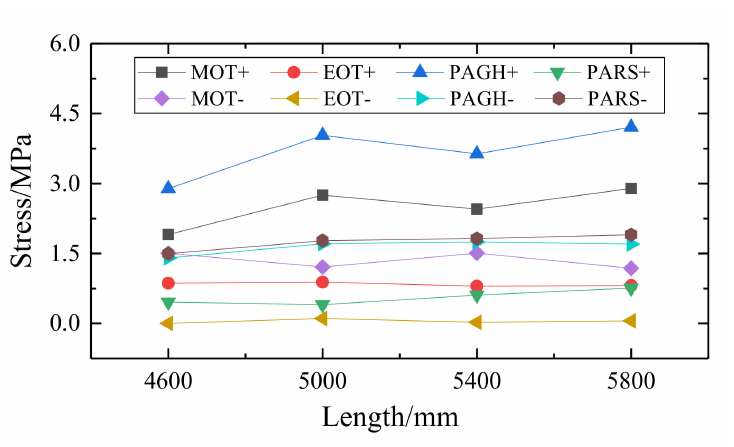
Figure 14. Influence of length on temperature stress of track slab (In legend identification, “+” means positive temperature gradient; “ − ” means negative temperature gradient).